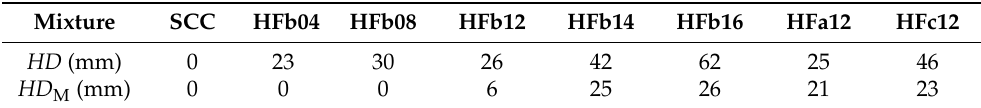
Table 4. The height difference of fresh concrete between inside and outside of the J-ring. Figure 6. Passing ability of fresh mixtures tested by using modified rebar spacing of the J-ring.